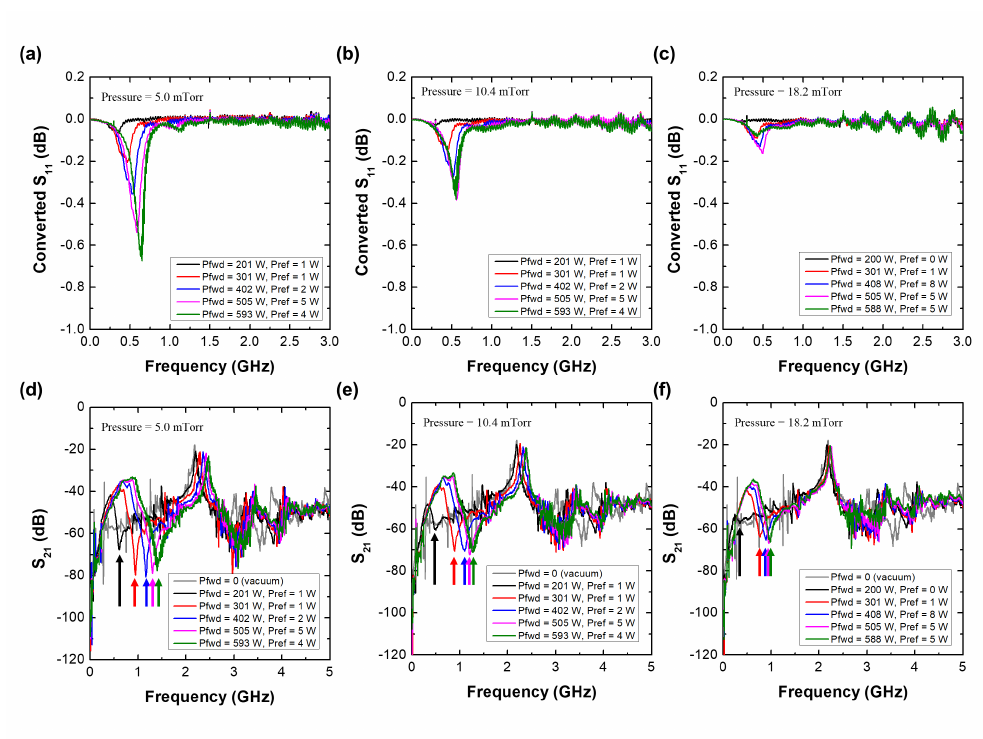
Figure 8. ( a – c ) Converted S 11 spectra [defined as S 11 (plasma)–S 11 (vacuum)] of the MOLE probe. ( d – f ) S 21 spectra of the cutoff probe at various rf powers (201–593 W) and pressures (5.0–18.2 mTorr).